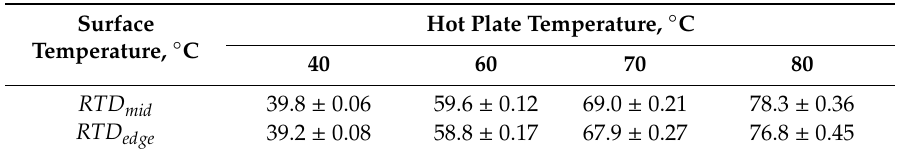
Table 2. Measured temperatures on material sample at di ff erent temperatures of the hot plate. The mean values and standard deviations are obtained from five di ff erent